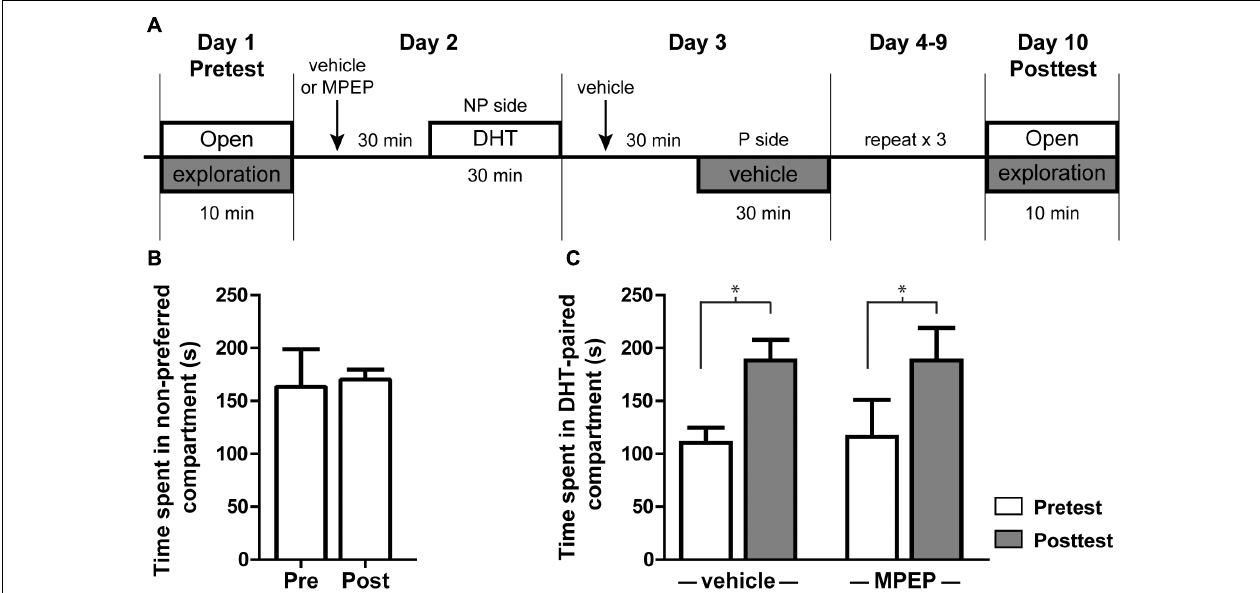
FIGURE 6 | DHT conditioned place preference is not dependent on mGluR5. (A) Schematic of conditioned place preference behavior. Initial preference was determined with a 10 min open exploration pretest on Day 1. On the following 8 days animals were given an i.p. injection of either vehicle or MPEP, then 30 min later were given an i.p. injection of DHT and contained on the non-preferred side (NP) or vehicle and contained on the preferred side (P). On day 10, animals were allowed to freely explore the apparatus for 10 min during the posttest period. (B) Time spent on the non-preferred compartment during the pretest and posttest for animals injected with vehicle 30 min prior to conditioning and vehicle on both sides of the conditioning apparatus. (C) Effect of pretreatment with veh/MPEP on time spent in the DHT-paired compartment. n = 7–8 animals per group, ∗ p <